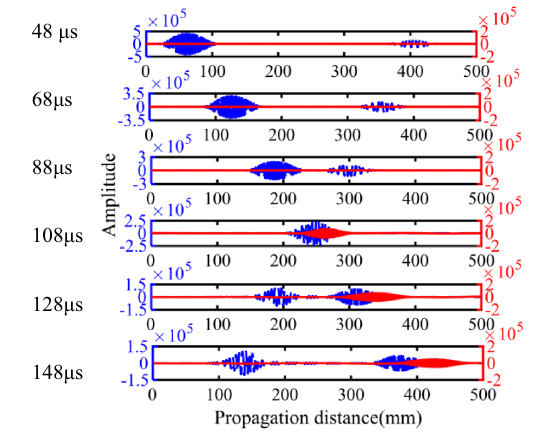
Figure 9 Images of U 2 (blue) and U 1 (red) displacement components along the